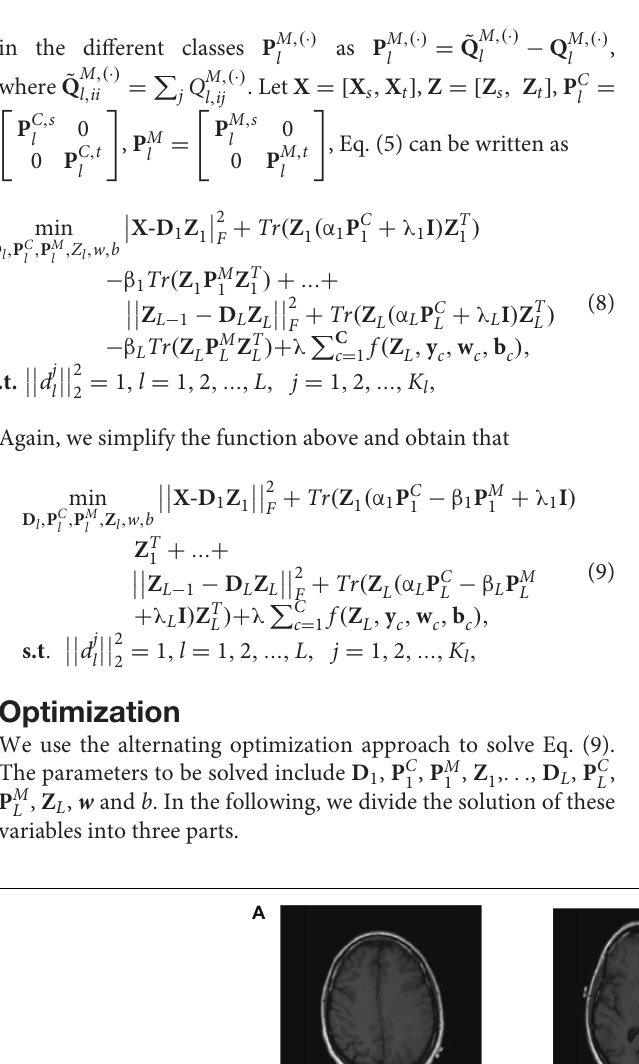
Frontiers in Neuroscience |